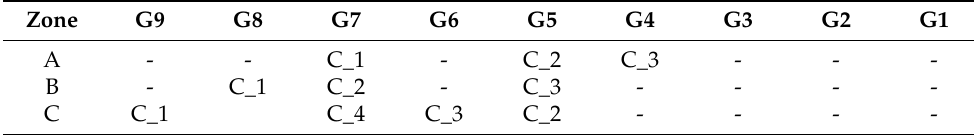
Table 1. Matrix of the SPS with a control signal in each generation